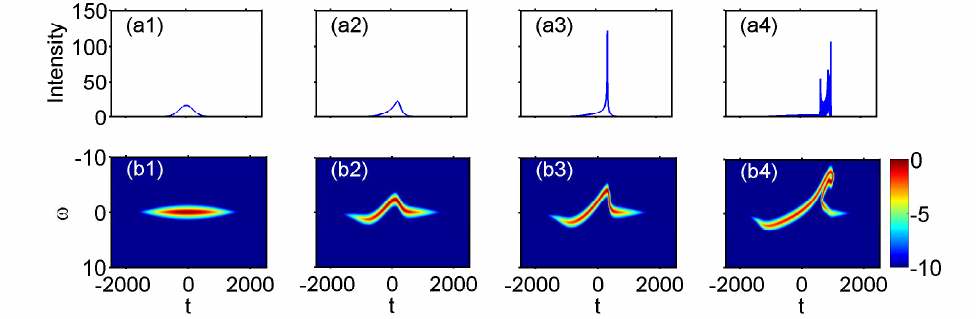
Figure 7. Coherent dynamics: Numerical simulation of the NLS Equation (1) showing the evolution of the intensity | ψ | 2 ( t , z ) ( a ), and corresponding spectrogram ( b ), with the same parameters as in Figures 1 and 2, except that the initial condition is a fully coherent pulse. The coherent field exhibits a shock-collapse singularity and develops an incoherent behavior after the singularity. The corresponding propagation distances are z = 0,120,200,300 from left to right.